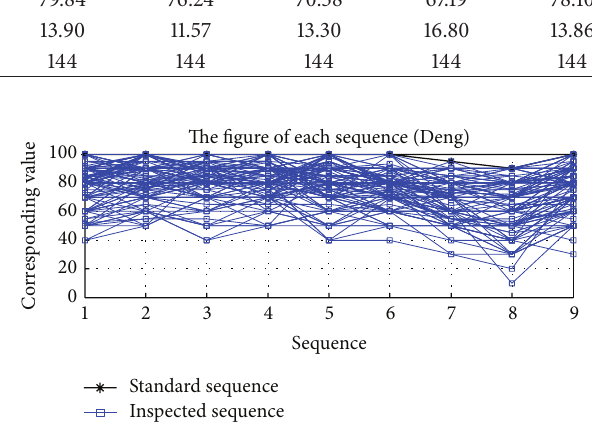
Figure 2: Output chart of grey relational grade of eight satisfaction